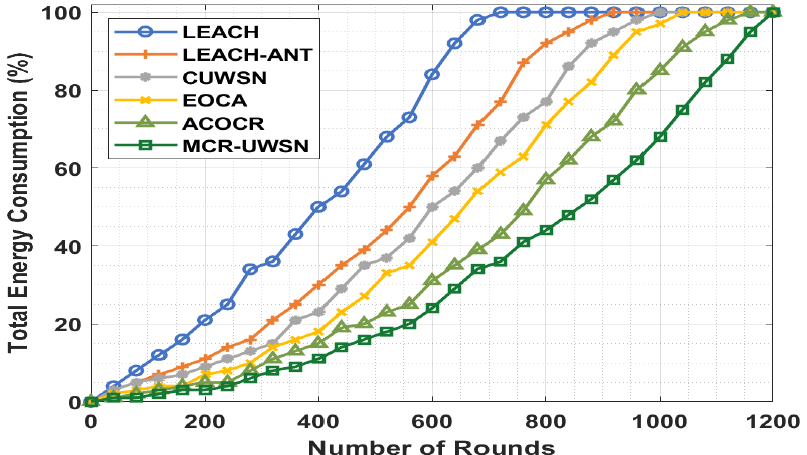
Figure 5. TEC analysis of MCR-UWSN method under distinct rounds.